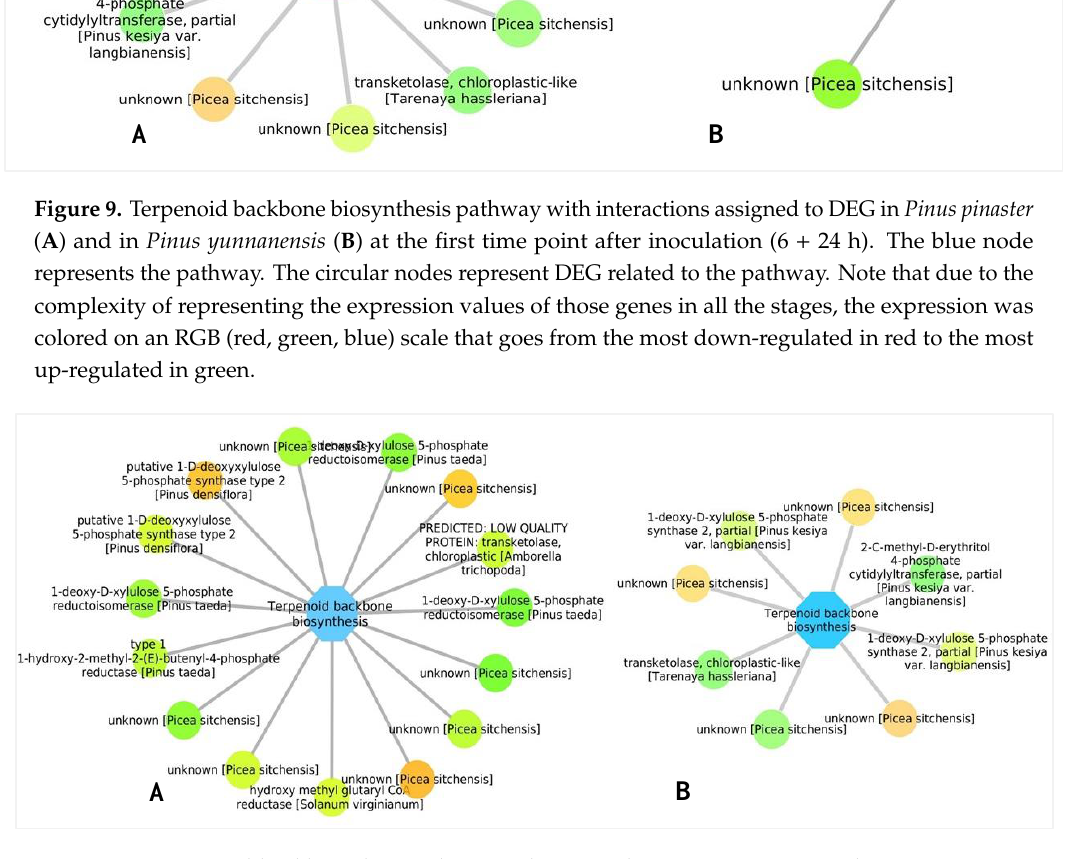
Figure 10. Terpenoid backbone biosynthesis pathway with interactions assigned to DEG in Pinus pinaster ( A ) and in Pinus yunnanensis ( B ) at the second time point after inoculation (48 h). The blue node represents the pathway. The circular nodes represent DEG related to the pathway. Note that due to the complexity of representing the expression values of those genes in all the stages, the expression was colored on an RGB scale that goes from the most down-regulated in red to the most up-regulated in green.